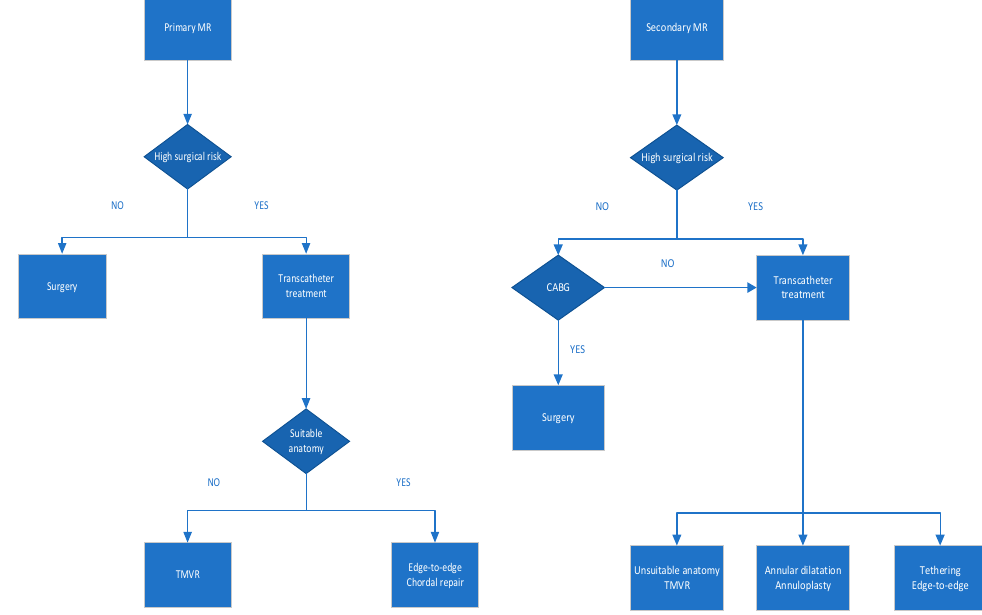
Figure 3. Selection of the most appropriate therapeutic strategy. CABG: coronary artery bypass grafting.